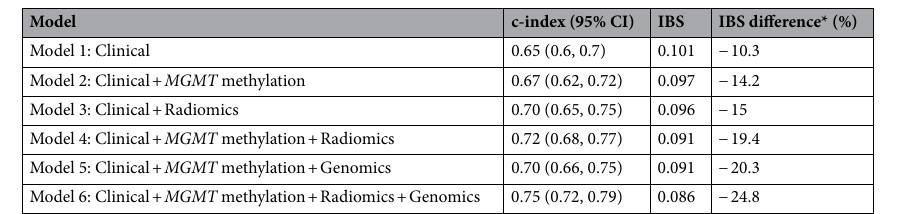
Table 2. Performance metrics for the Cox-PH models. † CI confidence interval. *The difference of IBS calculated from the Cox model compared to the reference IBS, which is equal to 0.113 in our study.